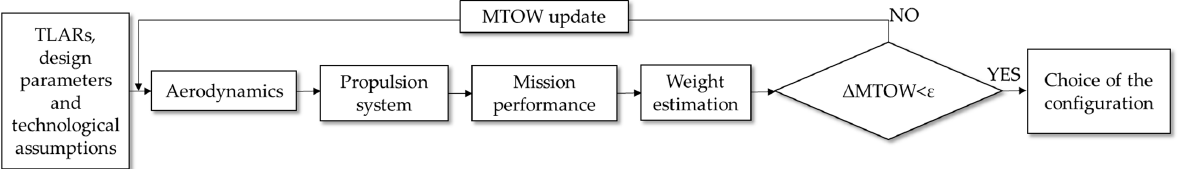
Figure 2. Conceptual design workflow for e-VTOL aircraft.